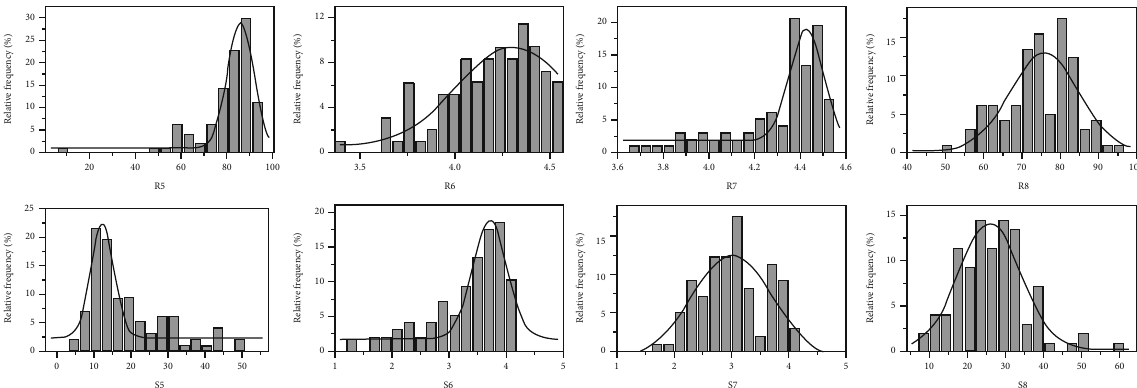
Figure 5: Probability density distribution of the random variables in the rationality of the engineering geology practice route ( R 5 – R 8 , S 5 – S 8 ).